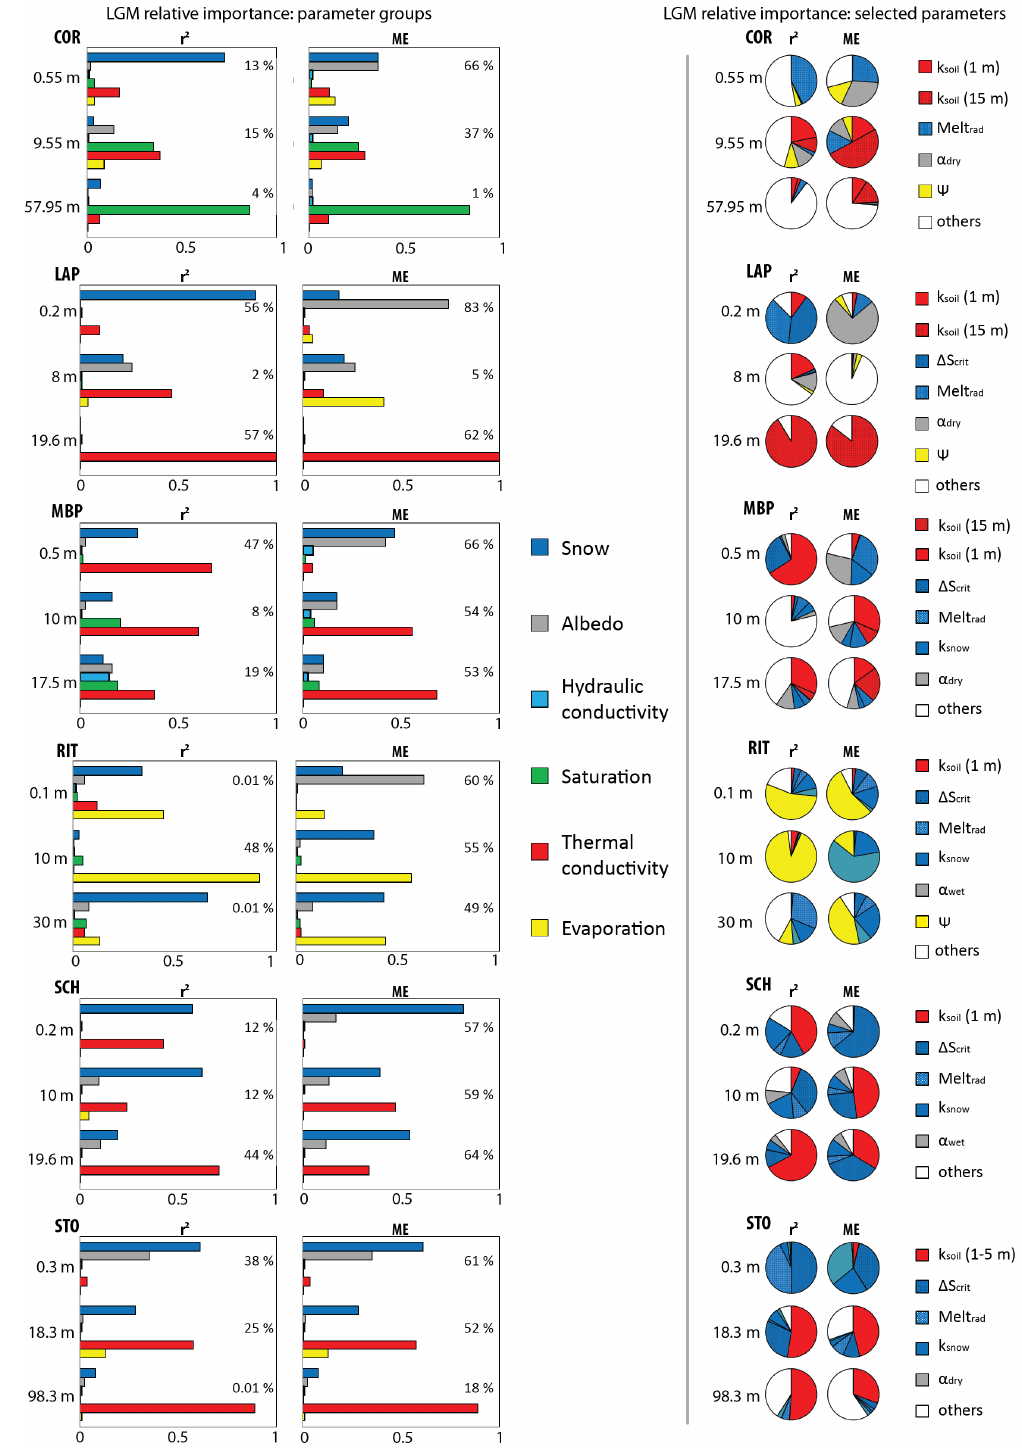
Figure 5. Left panel: LGM relative importance of six groups of parameters (snow, albedo, hydraulic conductivity, saturation, thermal con- ductivity and evaporation) on the r 2 (left row) and the ME (right row) at three different depths. The percentage indicates the total LGM absolute importance. Right panel: LGM relative importance of the most sensitive parameters that were selected for the second step of the calibration